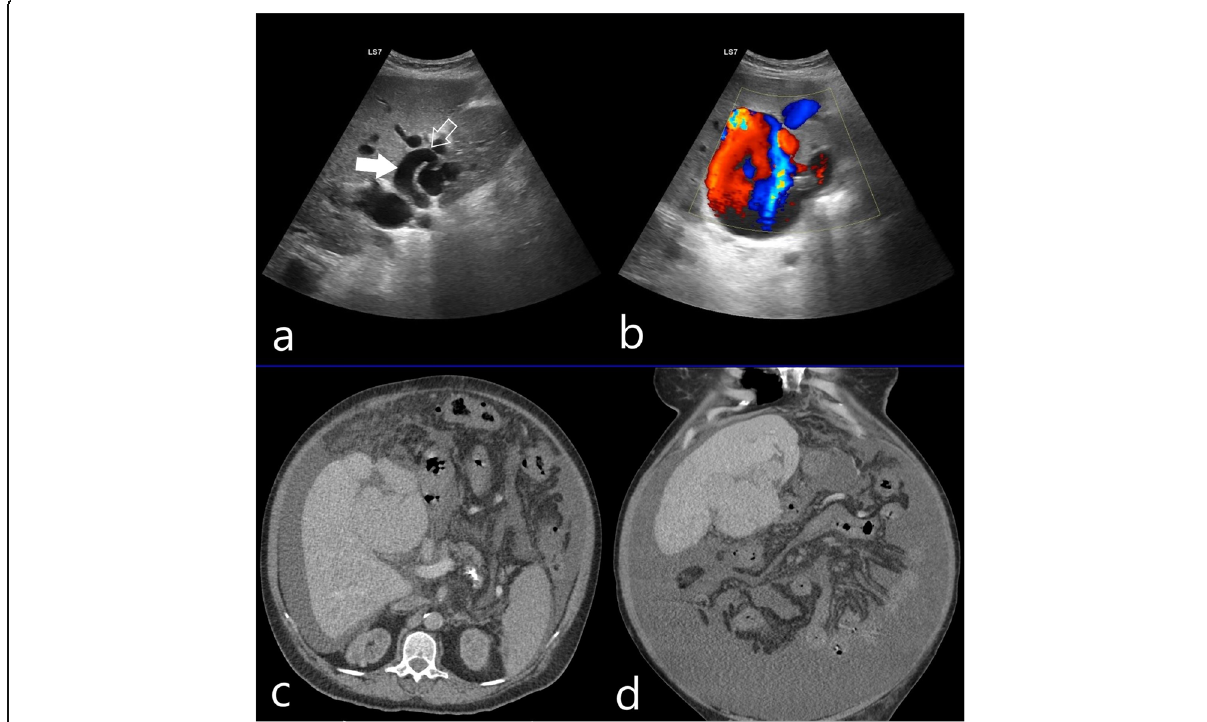
Fig. 1 RDUS view ( a and b ) showing the direct connection (hollow white arrow) between dilated hepatic artery (solid white arrow) and portal vein ( a ); Large saccular aneurysm formation between left hepatic artery and portal vein ( b ). Portal phase CT ( c , d ) confirms US findings and demonstrates massive